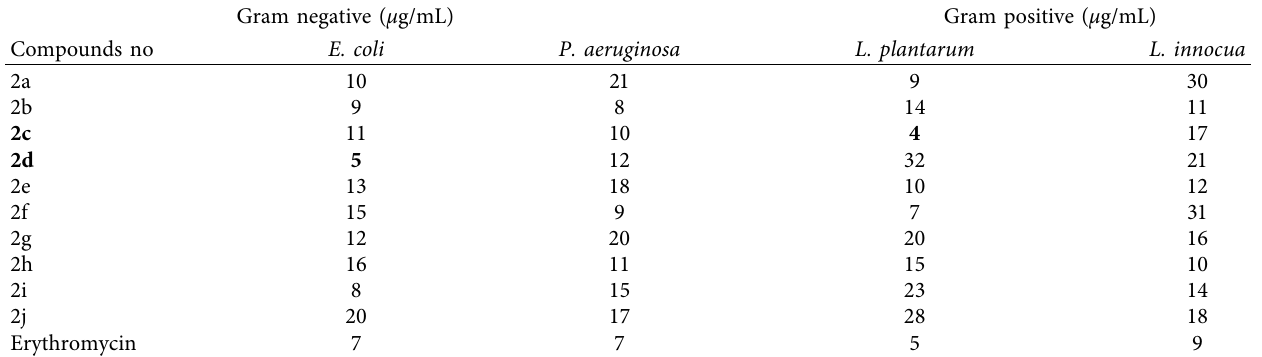
Table 2: Antibacterial activity of Gram-negative and Gram-positive for compounds 2a-2j with their MIC values.